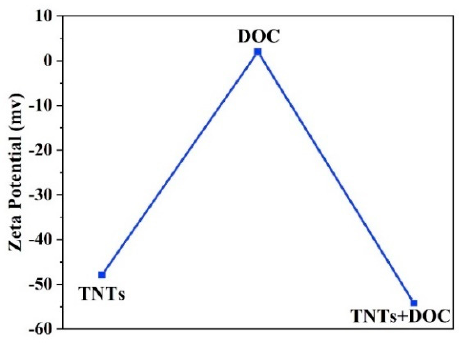
Figure 7. Zeta potential values of TNTs, DOC, and TNTs loaded with DOC.